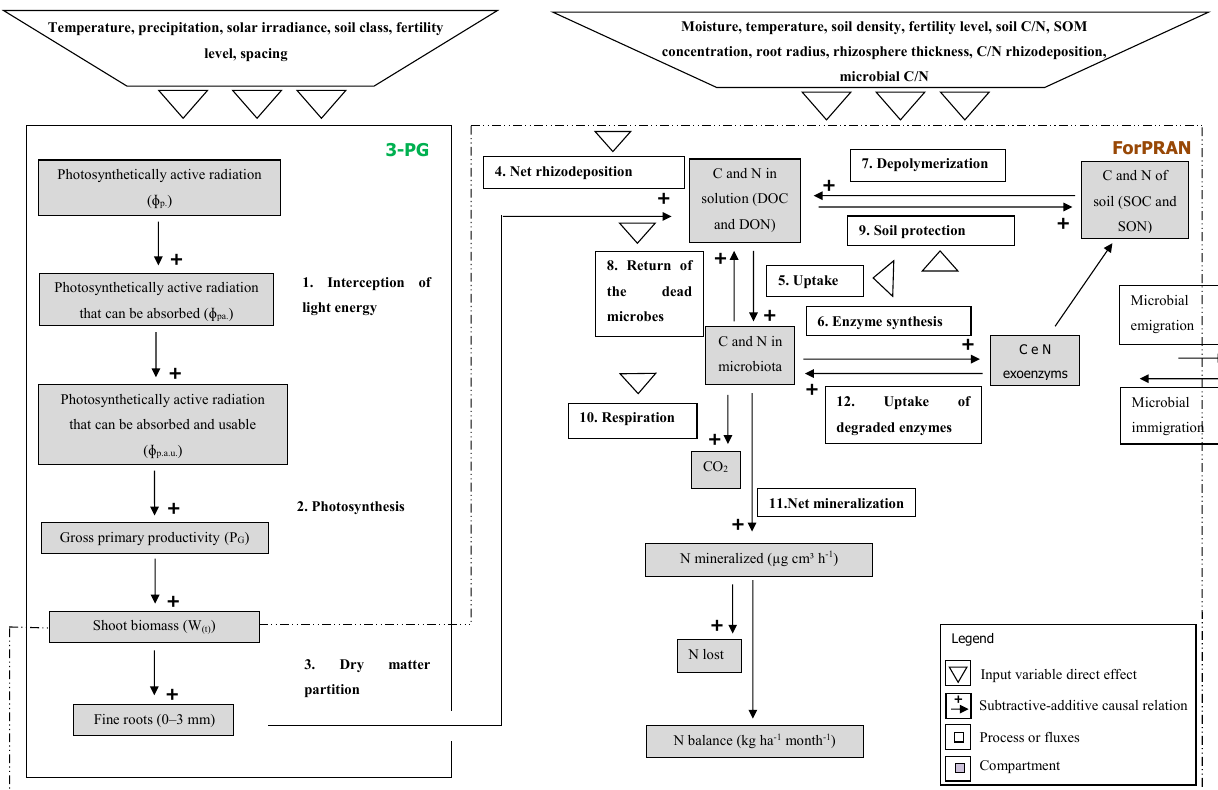
Figure 2. Flow chart of processes represented in the ForPRAN model.